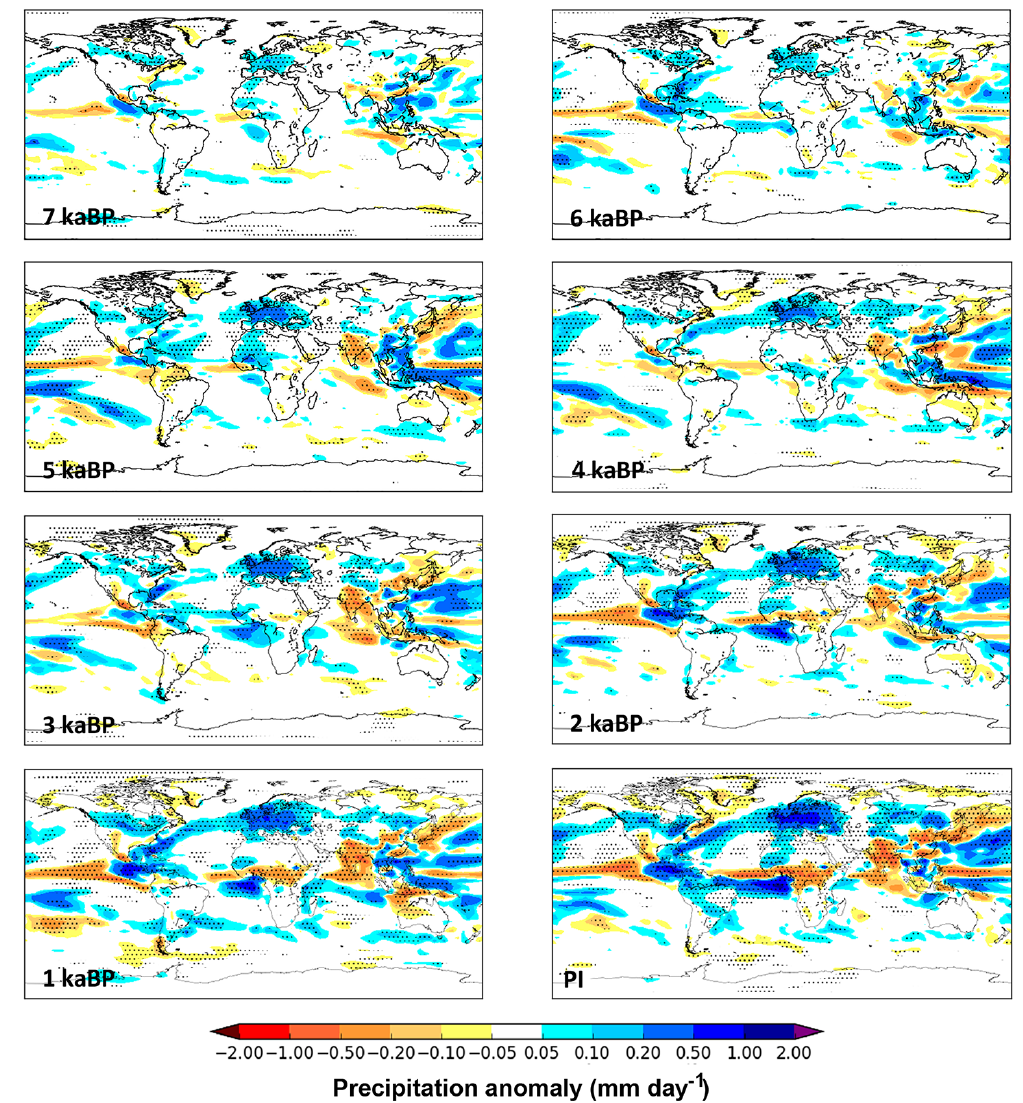
Figure 8. JJA precipitation anomalies (mmday − 1 ) for KK10 minus control at time slices from the late pre-industrial period (1850CE) to 7kaBP. The stippling indicates grid boxes where the anomalies are significant at the 95% level using Wilcoxon rank sum statistical